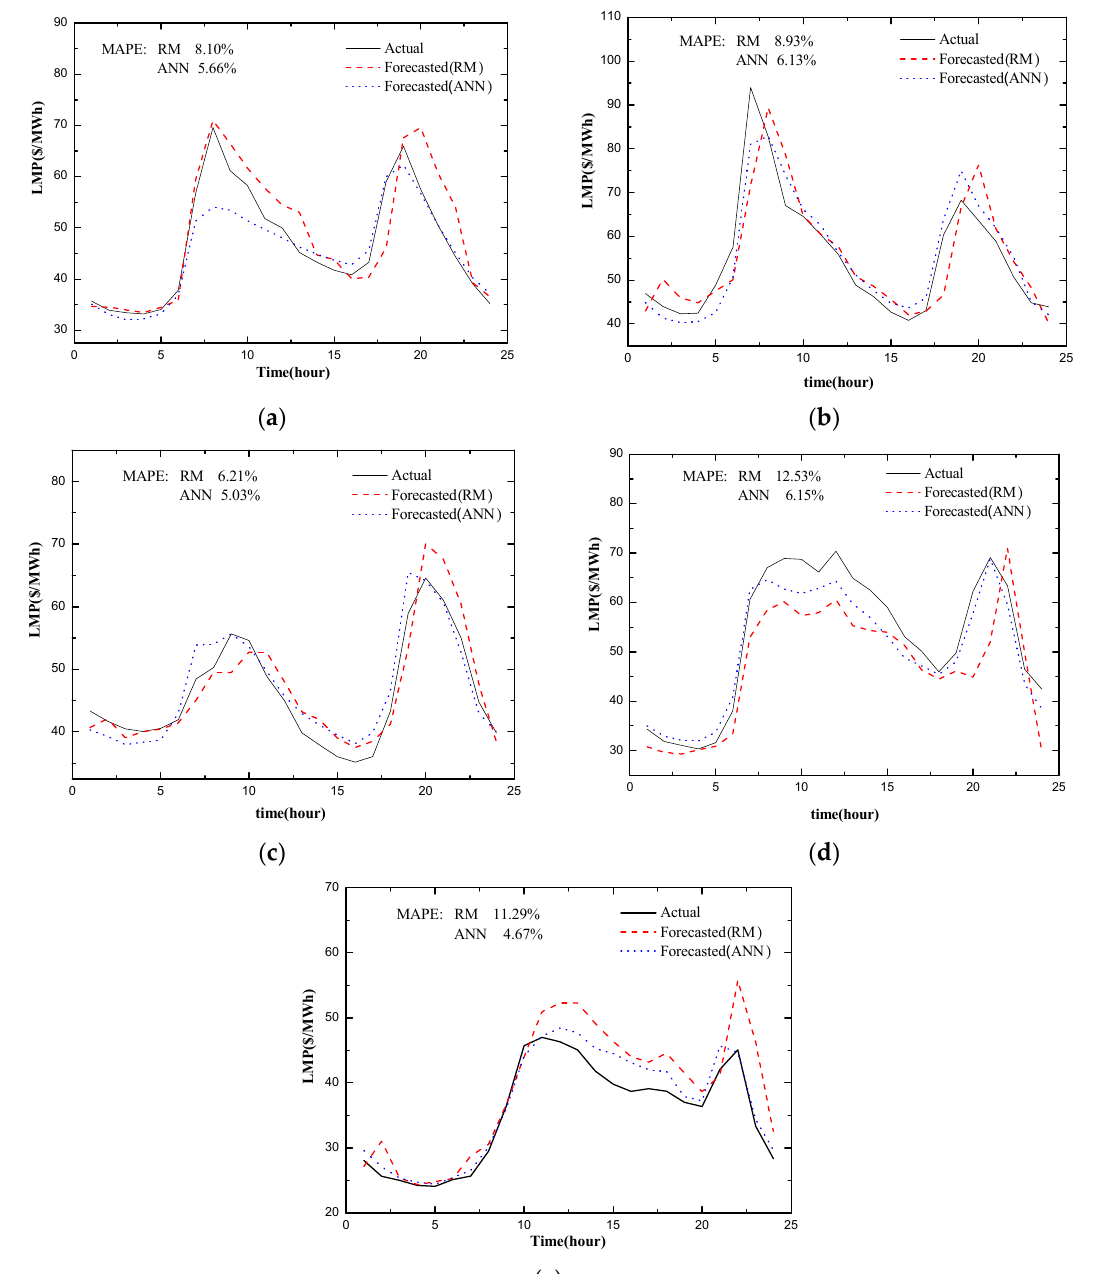
Figure 7. Results of regression model and neural network forecast price (2006). ( a ) 20 January, ( b ) 10 February, ( c ) 5 March, ( d ) 7 April, ( e ) 13 May.